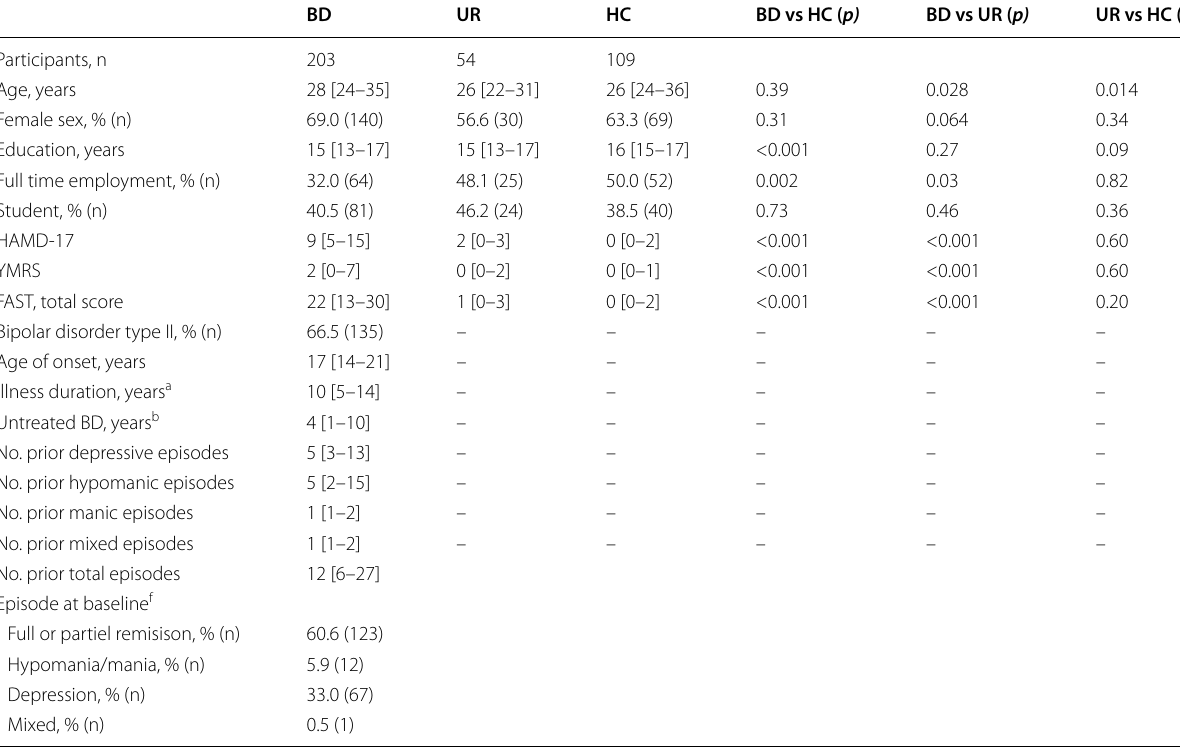
Table 1 Socio-demographic and clinical characteristics of patients with bipolar disorder (BD), unaffected first-degree relatives (UR) and healthy control individuals (HC) at